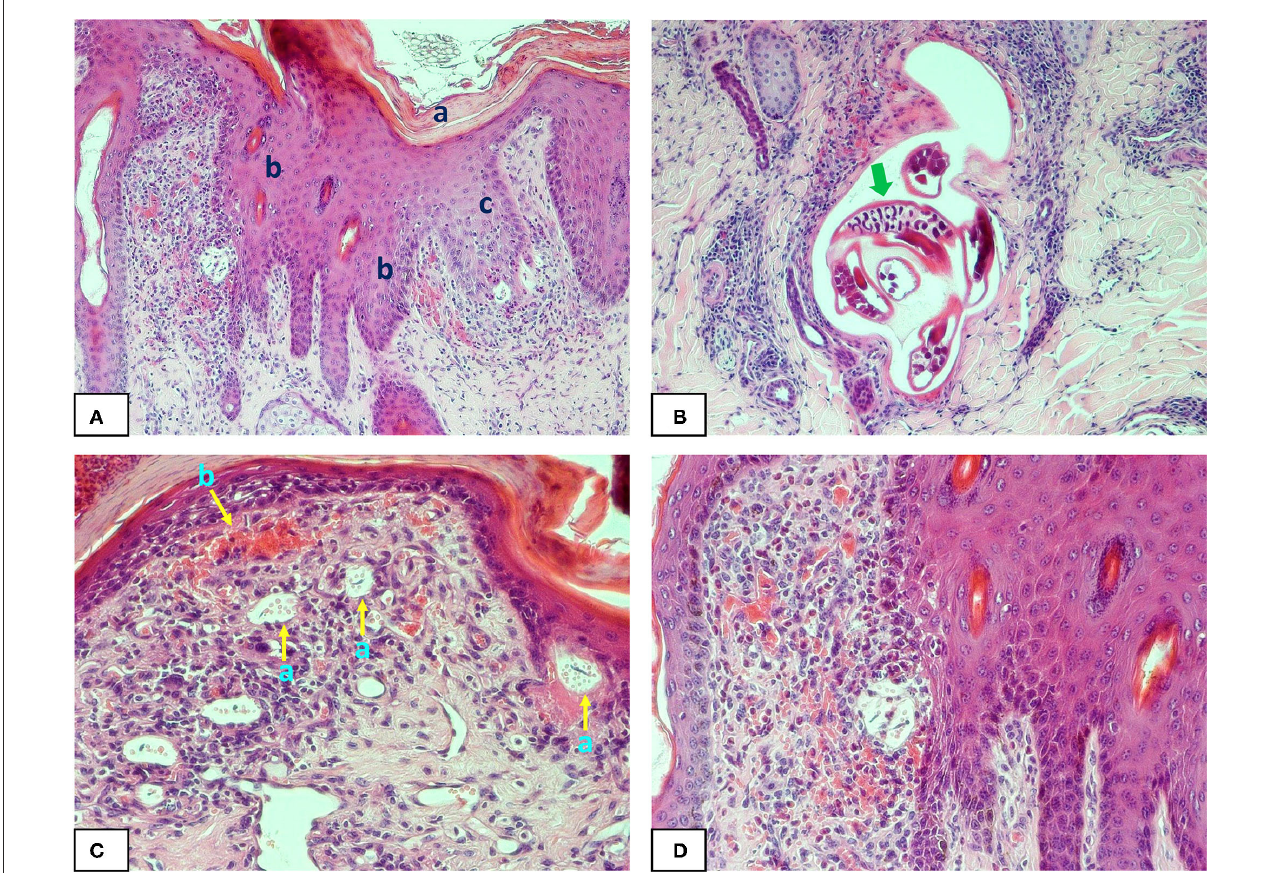
FIGURE1 Photomicrographs of buffalo fly lesion histology: (A) shows hyperkeratosis (a) acanthosis (b) and spongiosis (c) in the epidermal layer of a Stephanofilaria infected lesion (100X); (B) shows adult Stephanofilaria in a cyst-like structure surrounded by inflammatory cells. The arrow shows the microfilariae within the gravid uterus of an adult female nematode (200X); (C) Shows microfilariae close to the epidermis and enclosed in a round to oval-shaped vitelline membrane that also contains numerous small spherical eosinophilic bodies (a) and hyperaemia (b) with extensive inflammation in the superficial dermis (200X); (D) shows acanthosis, severe hyperaemia and eosinophilic inflammation in Stephanofilaria -infected lesion